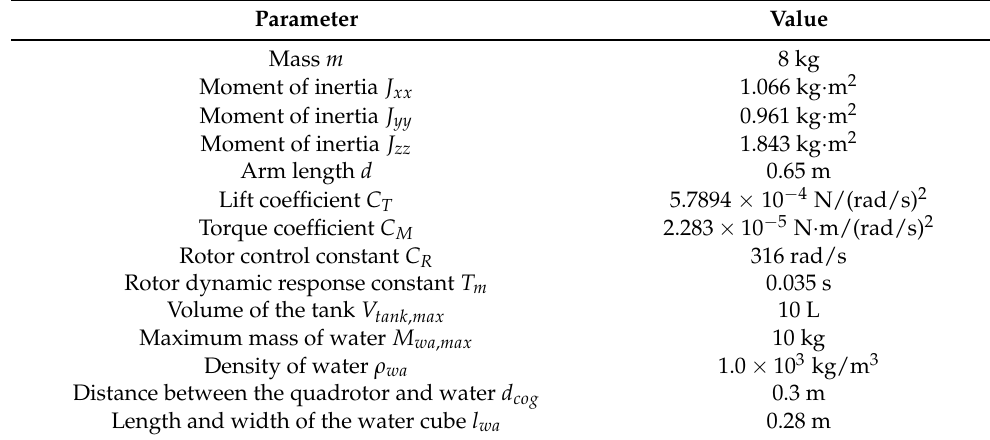
Table 1. Physical parameters of the quadrotor with an empty tank.